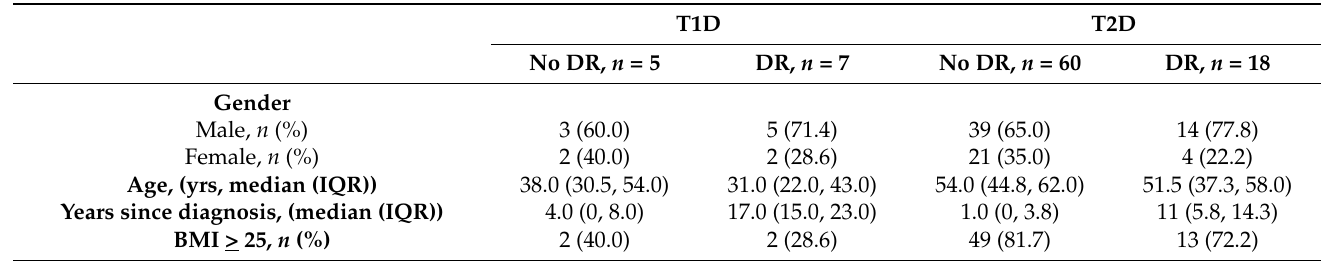
Table 1. Demographics of the studied population.